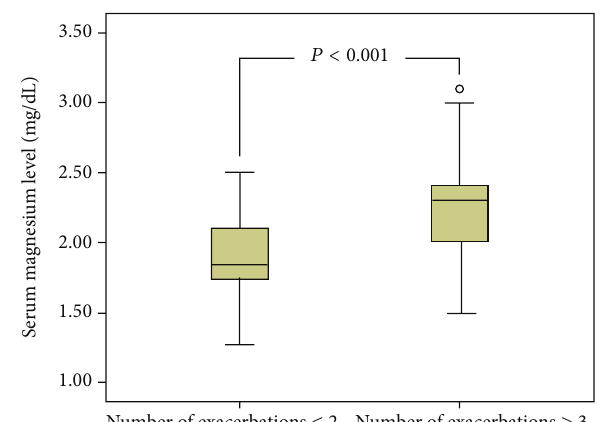
Figure 3: Box-plot showing the variation in magnesium levels between frequent and rare exacerbation groups.